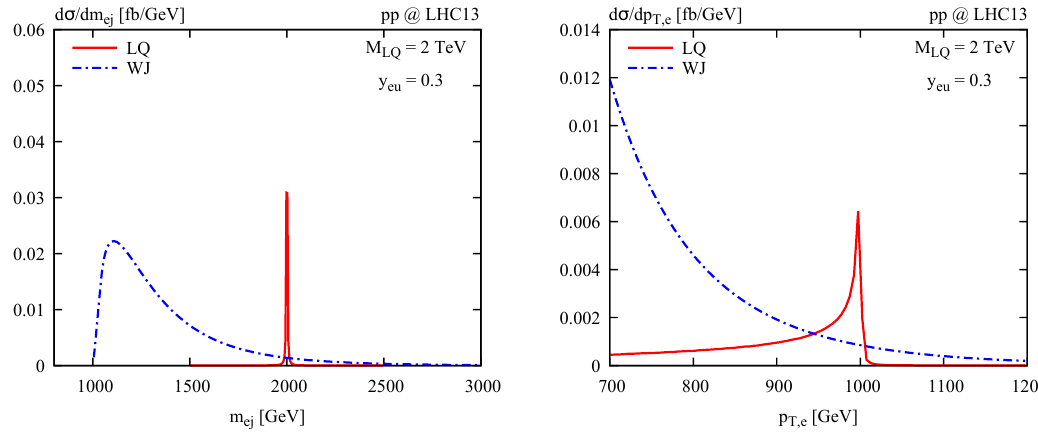
Figure 11. Invariant mass of the lepton plus jet system (left) and electron transverse-momentum (right) distributions. The signal (red line) is due to a LQ of mass M LQ = 2 TeV and Yukawa coupling y eu = 0 : 3 in the hypothesis of minimal coupling of the LQ between (cid:12)rst-generation quarks and leptons. W ( l(cid:23) )+1 jet background is shown in blue. The selection cuts are p T;l ; p T;j > 500 GeV,